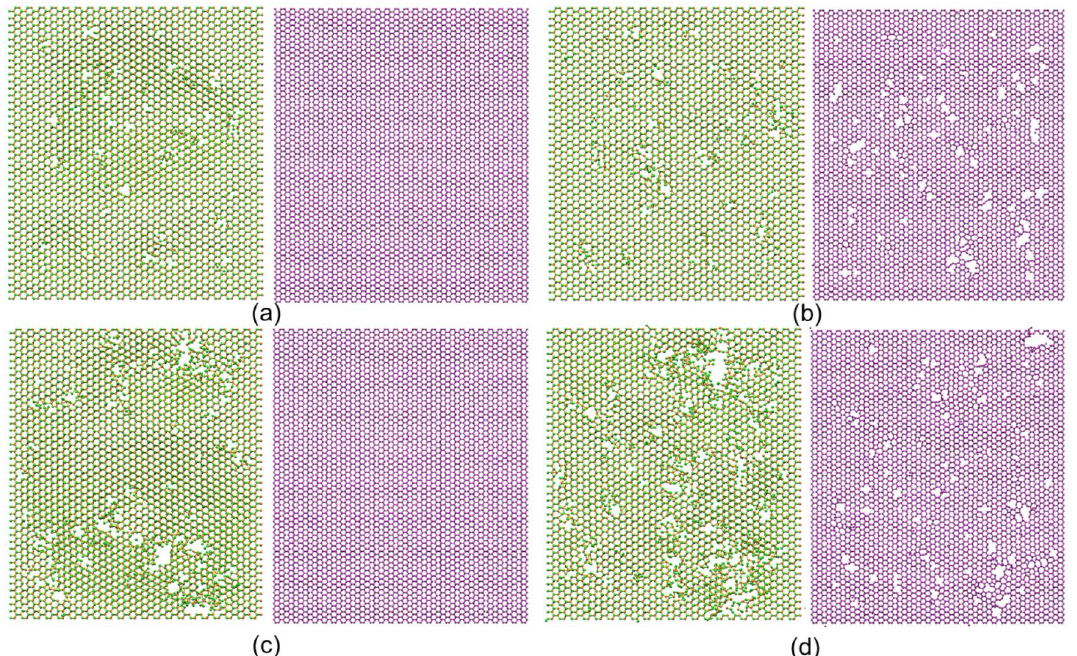
Figure 8. Morphologies of the MoS 2 and graphene in heterostructures for the suspended and supported cases. ( a ) Suspended case irradiated with 80 eV ions. ( b ) Suspended case irradiated with 400 eV ions. ( c ) Supported case irradiated with 80 eV ions. ( d ) Supported case irradiated with 400 eV